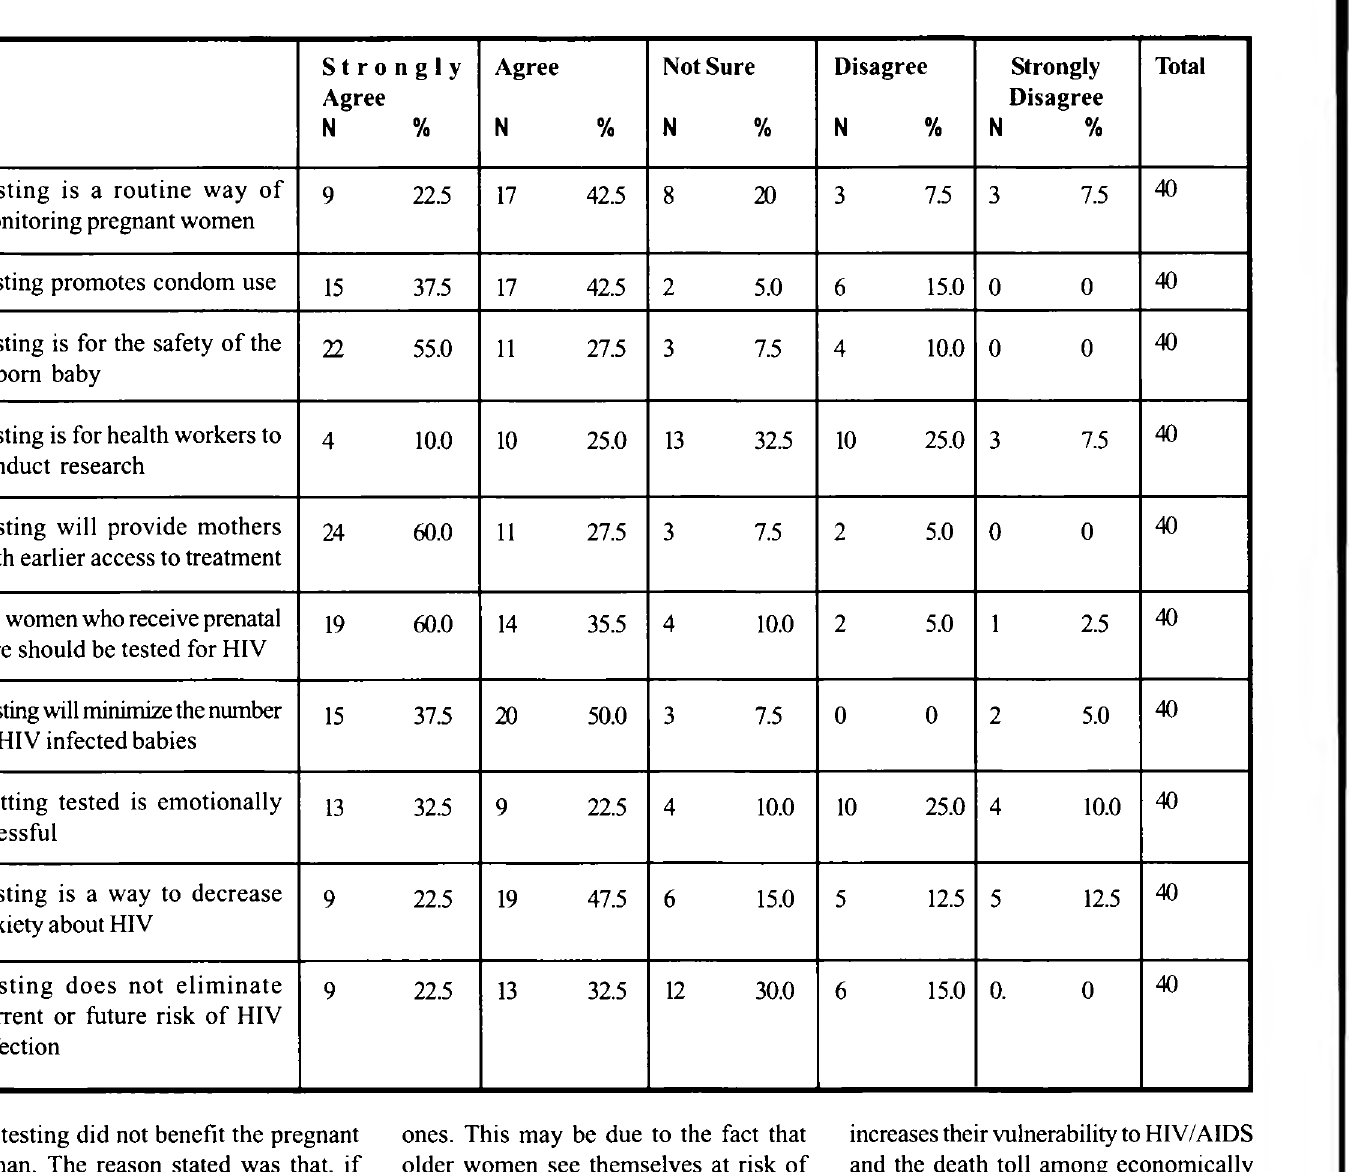
Table 1. Perceptions of pregnant women.